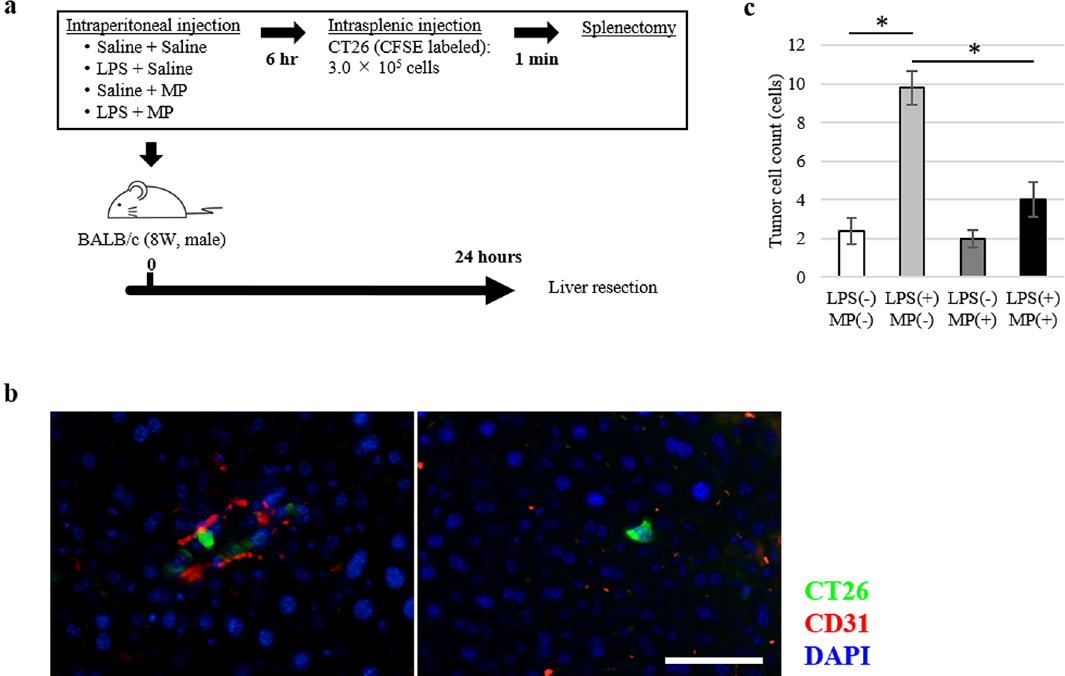
Figure 4. Suppressive effects of MP on tumour cell hepatic binding in LPS-induced murine hepatic metastasis models. ( a ) Mouse colon cancer cell line (CT26) hepatic metastasis model; male BALB/c mice (8 weeks old) were treated with saline/saline (control), LPS/saline, saline/MP, or LPS/MP. Six hours later, 3.0 × 10 5 CT26 cells were injected into the inferior pole of the spleen, followed by splenectomy 1 min later. After 24 h, the liver was resected for analysis. ( b ) Representative images of CT26 tumour cells adhered to the endothelial cells (left) and transmigrated into the liver (right). CT26 tumour cells are labeled by CFSE fluorescence (green). Each protein was co-stained with anti-CD31 antibody to define vascular endothelial cells (red). Nuclei are stained with DAPI (blue). Scale bars are equal to 50 µm. ( c ) Number of CT26 tumour cells binding to the liver following pretreatment with LPS and MP. Data are means ± standard error (n = 5, each group); * P <